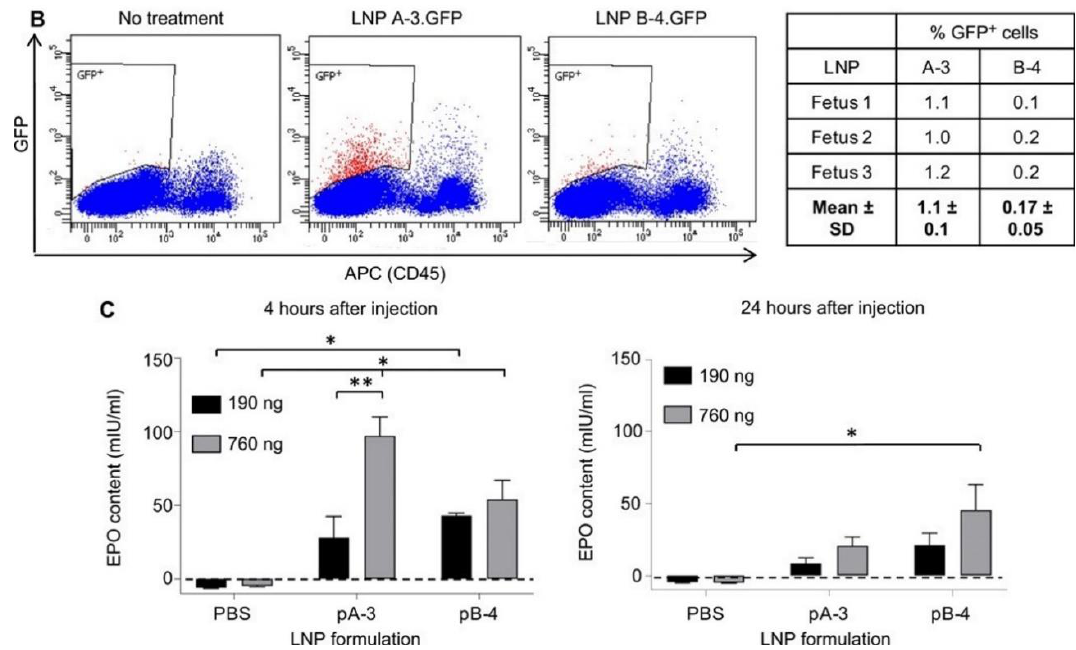
Figure 7. GFP mRNA and EPO mRNA were delivered in utero with LNPs. ( A ) GFP expression in fetal liver at 24 h post-injection. ( B ) Analysis of single cell suspensions from fetal liver by flow cytometry, recording the percentage of CD45 - and GFP + cells. ( C ) Levels of EPO in fetal liver after injection [207]. * p ≤ 0.05, ** p ≤ 0.01.